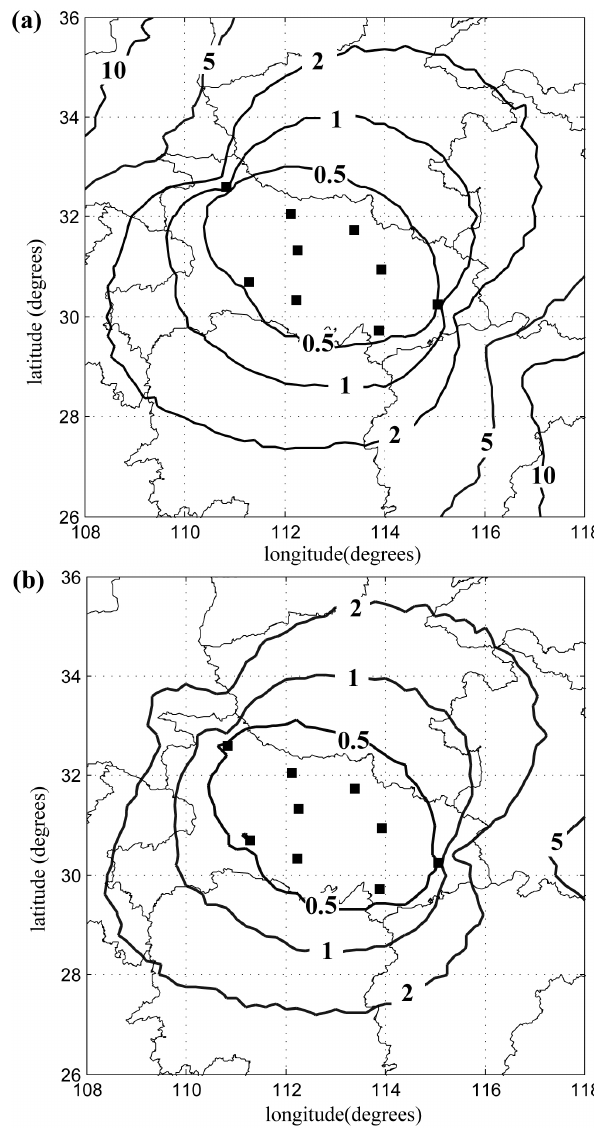
Fig. 10. Same as Fig. 7, except for the improved accuracy of the least square positions (in kilometer): (a) lightning source location using TOA measurement only, (b) lightning source location using both TOA and AOA